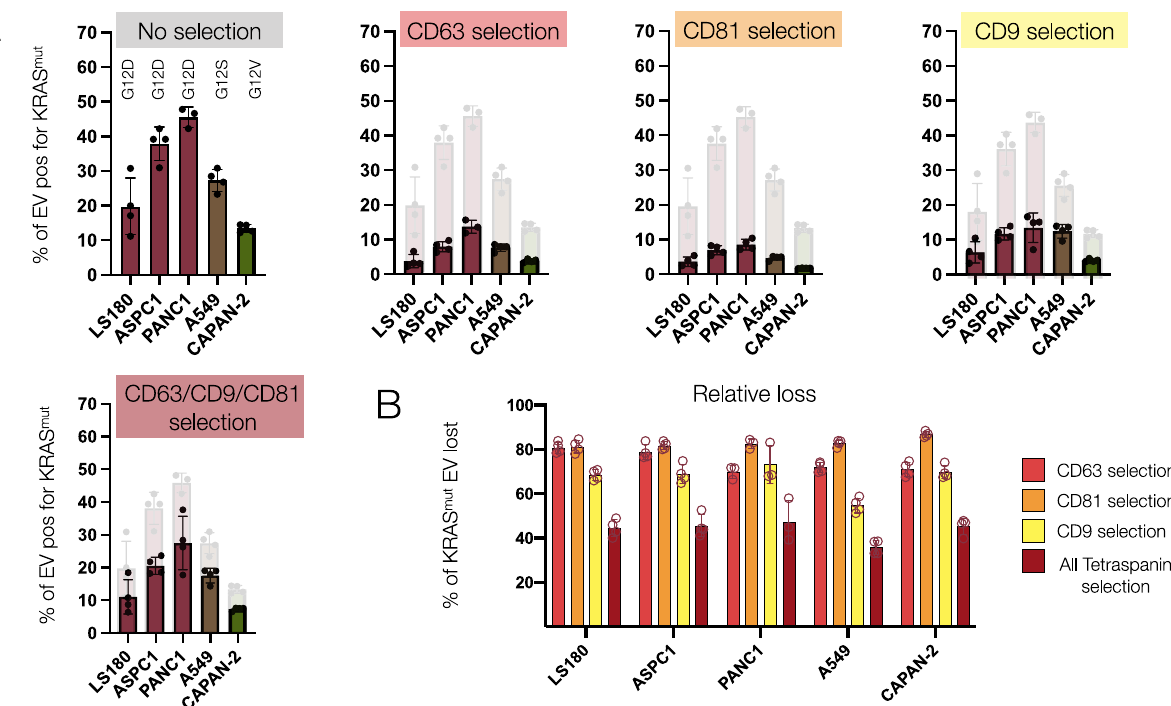
Fig. 5 | Analysis of EV carrying cancer-speci fi c KRAS mutated proteins. EV carrying cancer-speci fi c mutated proteins (KRAS G12D (PANC-1, ASPC1, LS180); KRAS G12V (CAPAN-2); and KRAS G12S (A549) were analyzed for co-expression of tetraspanins commonly used for af fi nity puri fi cation of EV (error bar: mean ± standard deviation). Number of EV analyzed: LS180: 5500; ASPC1: 6400; PANC-1: